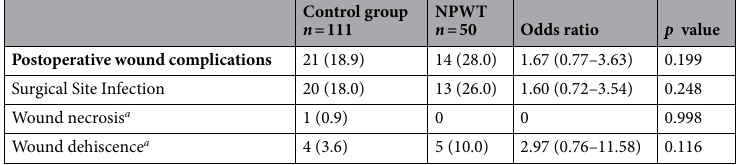
Table 2. Primary outcome: number of patients with postoperative wound complications requiring intervention (%). a Wound necrosis or dehiscence requiring surgical intervention.